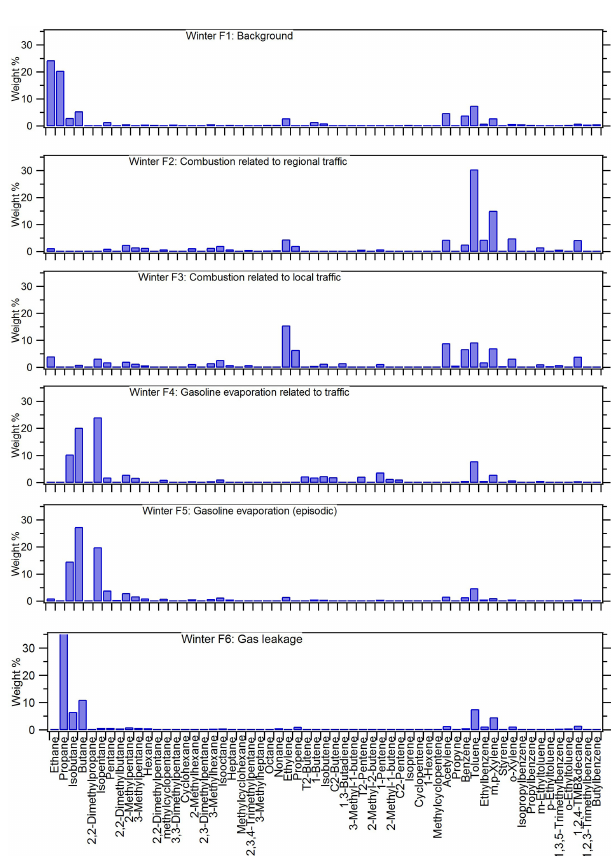
Figure 2. Source composition profiles (relative abundance of spe- cific compounds within each factor in wt%) in winter